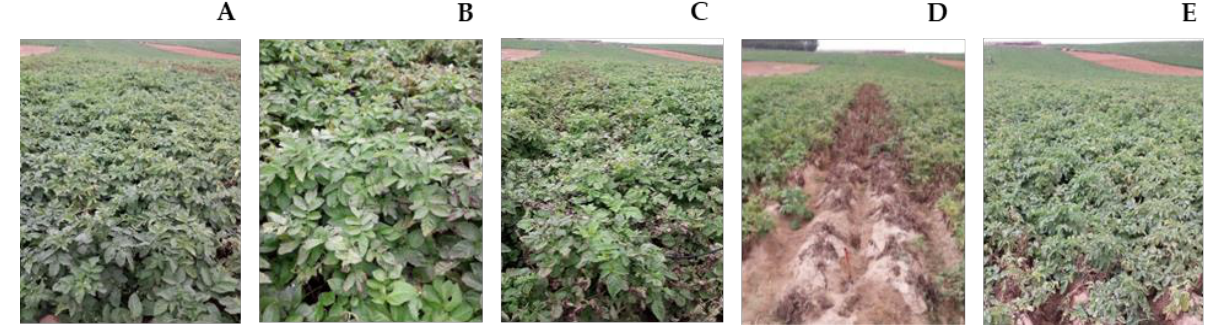
Figure 3. Production overview of S. tuberosum L. in Field A (Picasso variety) after six foliar appli- cations: ( A )—Control; ( B )—CaCl 2 12 kg · ha − 1 (12A); ( C )—CaCl 2 24 kg · ha − 1 (24A); ( D )—Ca-EDTA